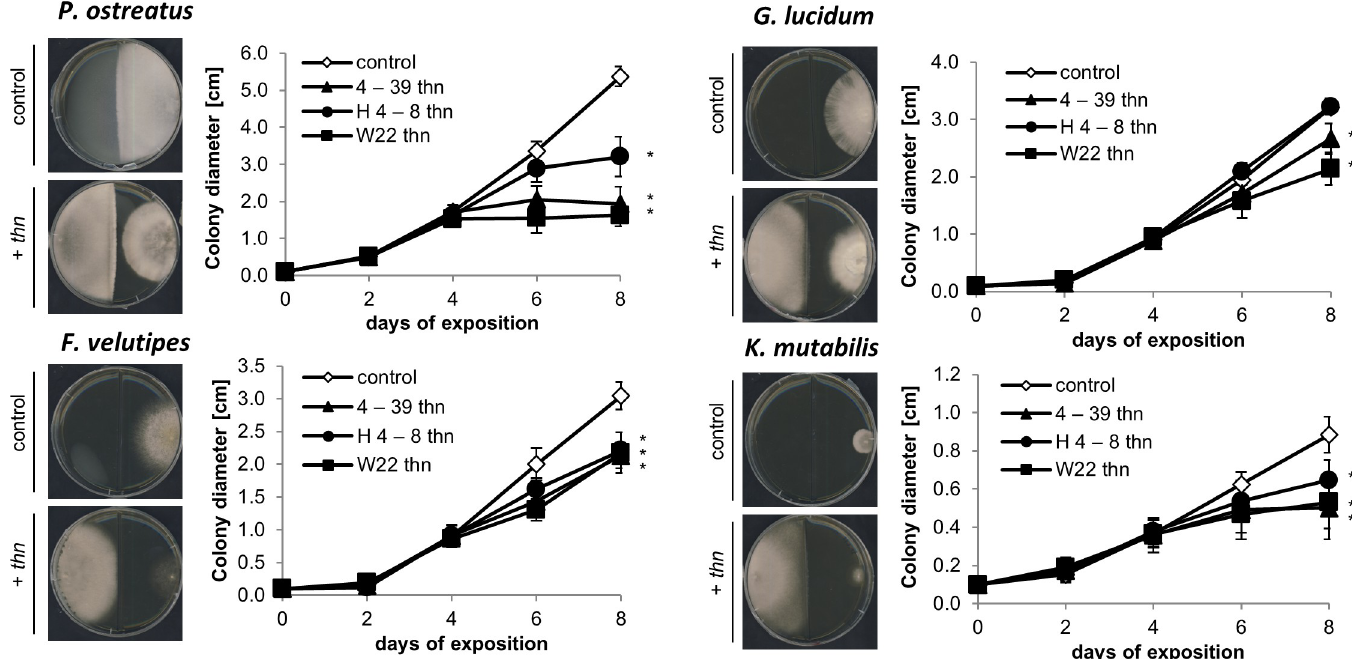
Fig 2. Effect of S . commune Volatile Organic Compounds (VOCs) on the growth of indicator fungi. P < 0.0001, n = 10.